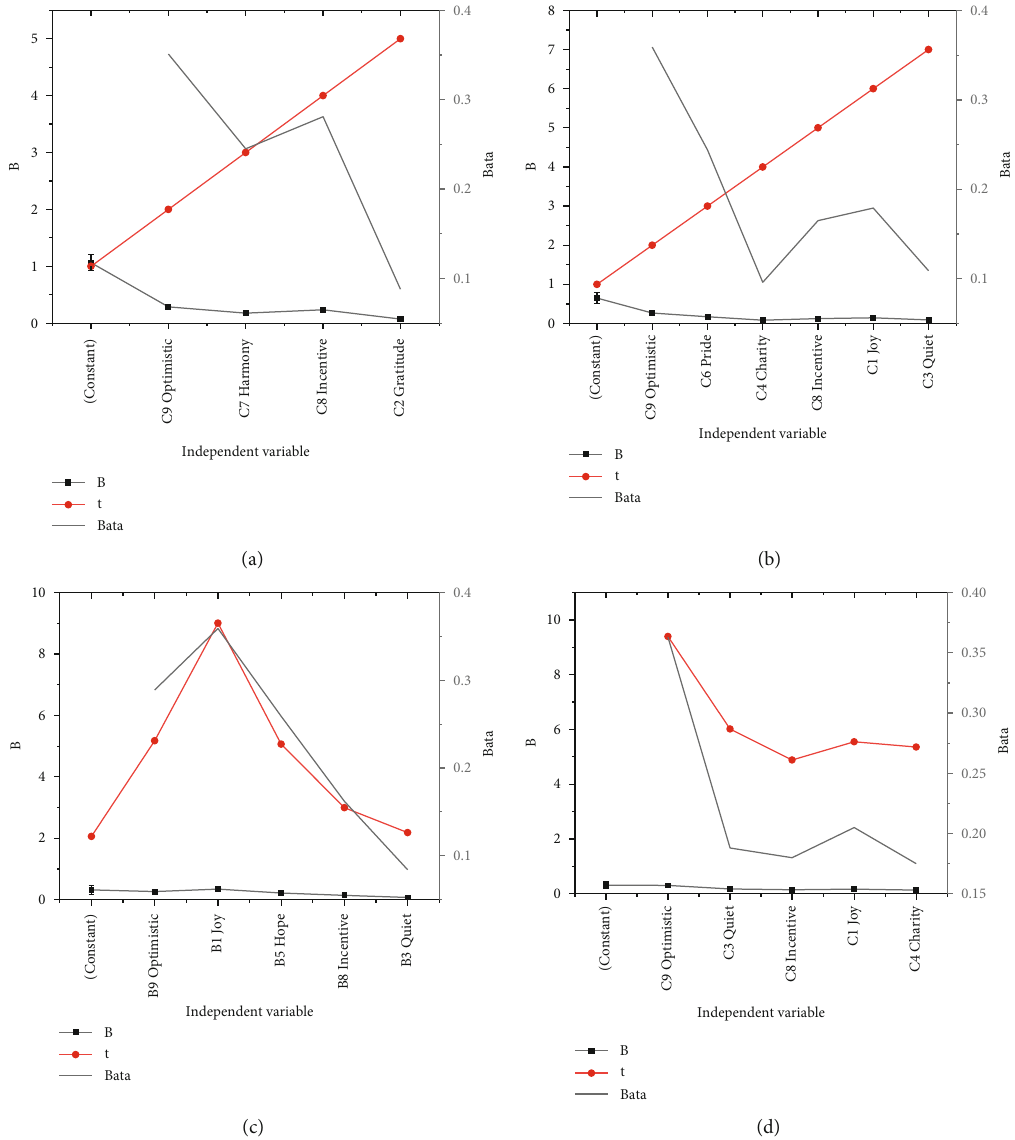
Figure 12: QS results of enhancement e ff ects of di ff erent music styles on positive emotions around the world ((a) “ Vienna Woods Waltz ” ; (b) “ Carmen ” ; (c) “ Remembrance ” ; (d) “ Balance ” ; B is nonstandardized coe ffi cient; t stands for the emotional